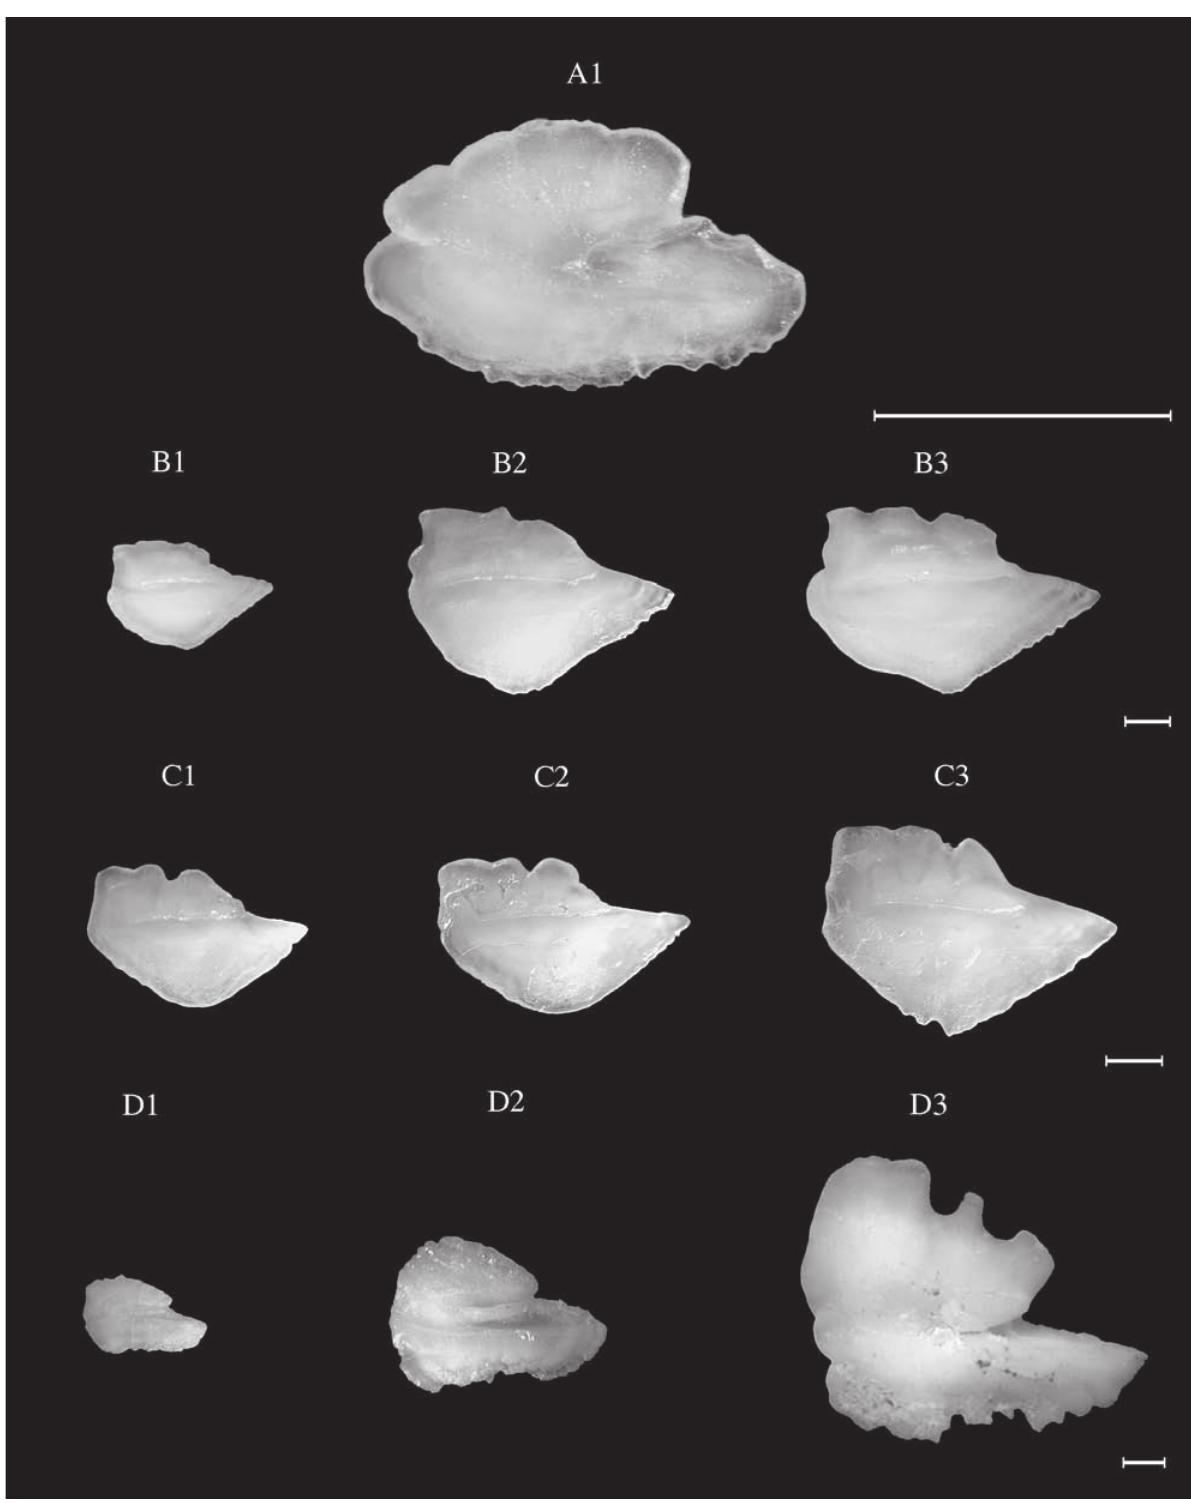
Fig. 17. – Sprattus sprattus (NEA) . TL: A1, 9.3 cm. Argentina sphyraena . TL: B1, 11.9 cm (NEA); B2, 17.0 cm (WM); B3, 22.6 cm (NEA). Glossanodon leioglossus (WM). TL: C1, 9.0 cm; C2, 10.5 cm; C3, 12.5 cm. Alepocephalus rostratus (WM). TL: D1, 7.5 cm; D2, 19.0 cm; D3, 44.0 cm. Scale bar = 1